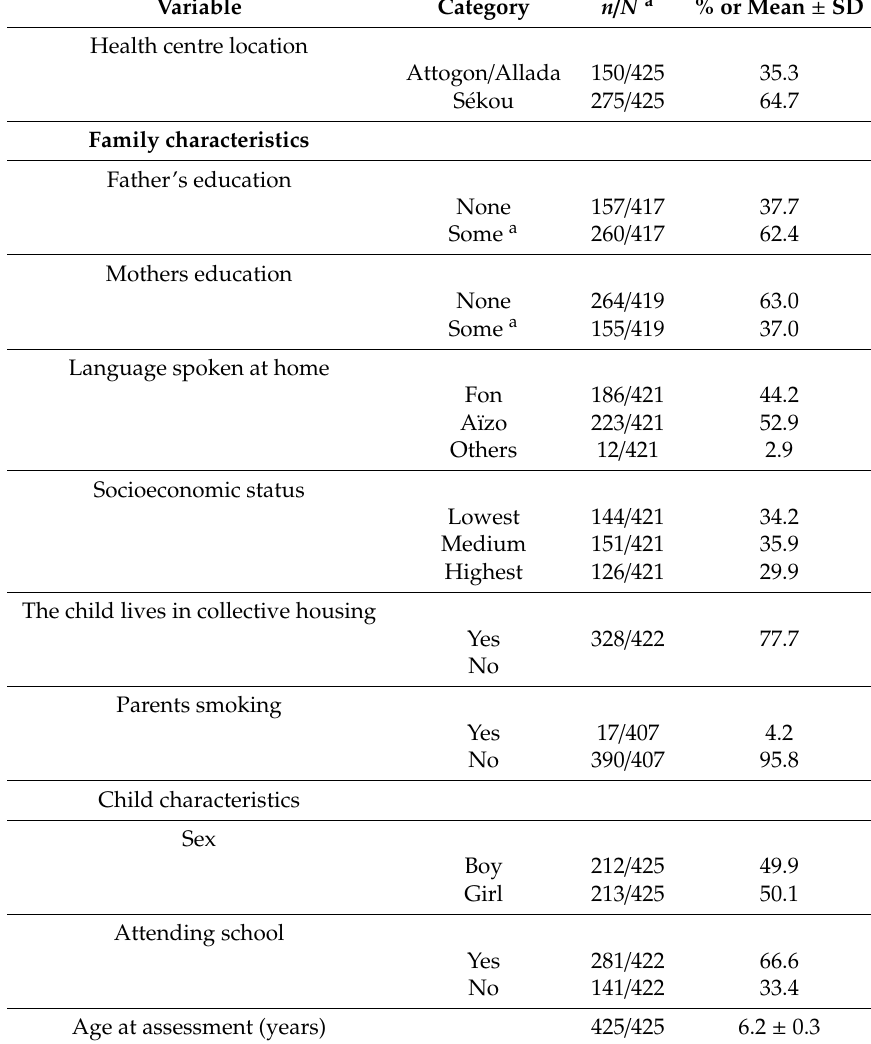
Table 1. Study population characteristics of children aged 6 years, 2016–2018 in Benin (N = 425). Variable